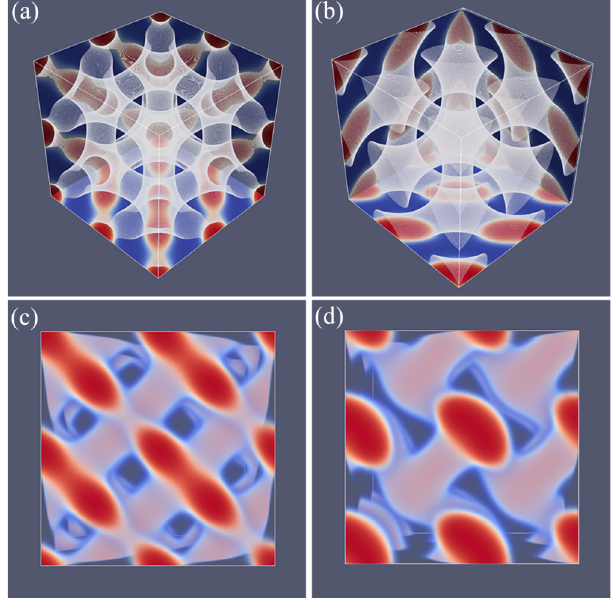
Figure 5. ( a , c ) Three-gradient equal density contour plots for eight unit cells of the double diamond DD phase ( b , d ) three-gradient equal density contour plots for eight unit cells of the hexagonal perforated lamellae HPL phase. For ( a , b ), the two phases are given in the orientation that reveals the three three-fold symmetry planes. In panels ( c , d ), we present a side view of eight unit cells (viewgraphs with x − y or y − z or x − z planes perpendicular to the viewing direction are all similar). The color coding is similar to the one given in Figure 3. Parameters for DD phase: D = 45, N = 300, χ N = 30 and f = 0.33, HPL phase: D = 43, N = 300, χ N = 30 and f =